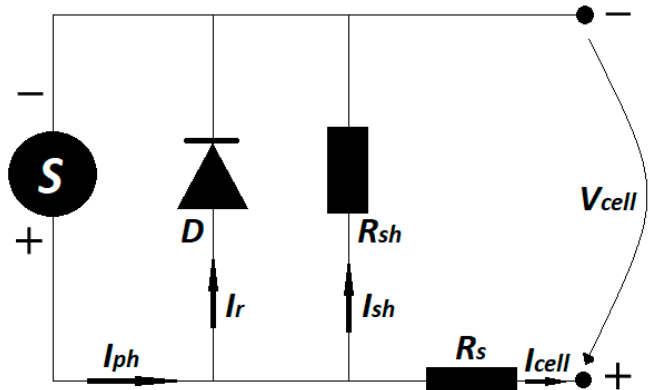
Figure 2. PV cell electrical model. S and D —photo-sensible and diode-type components of solar cell. R s , R sh —series and shunt resistance, respectively.